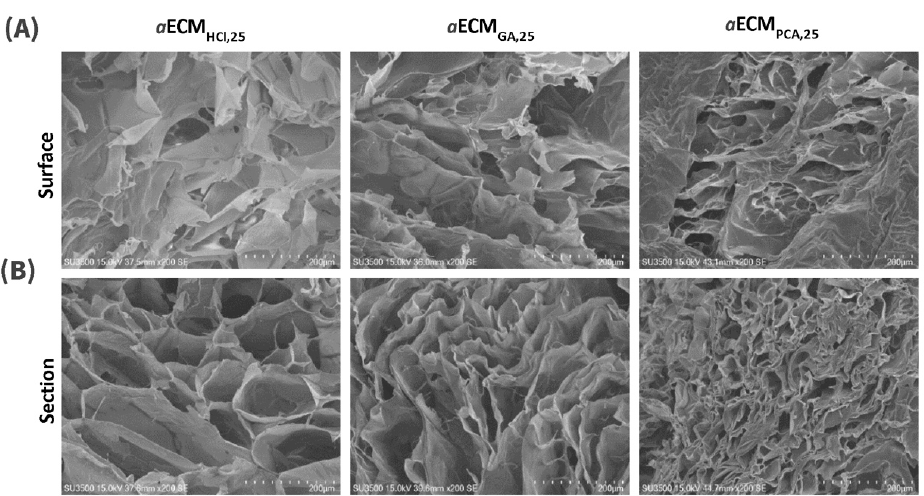
Figure 2. Rheological analysis of a ECM HCl,25 , a ECM GA,25 and a ECM PCA,25 at 25 ( A ) and 37 °C ( B ).